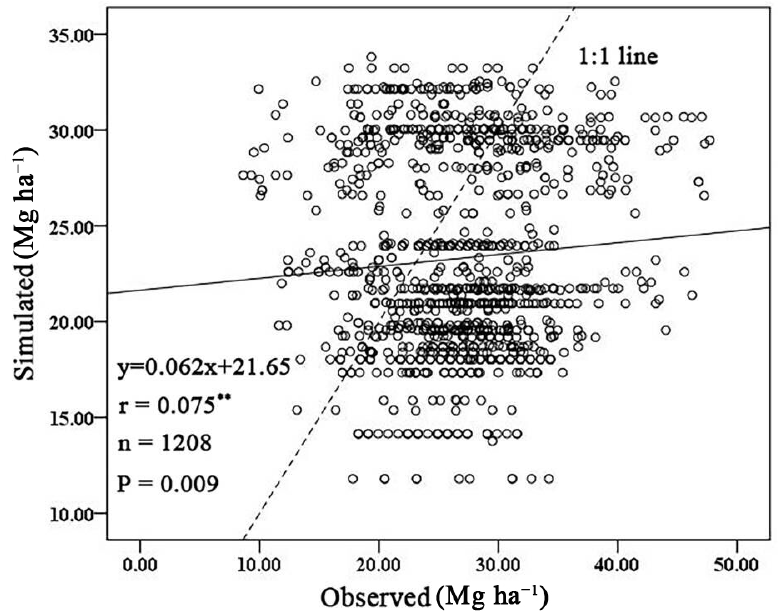
Figure 3. Comparison between simulated and observed soil organic carbon (SOC) density in 2008 in the non-vegetable area of Cangshan County. ** denotes p < 0.01. the non-vegetable area of Cangshan County. ** denotes p <